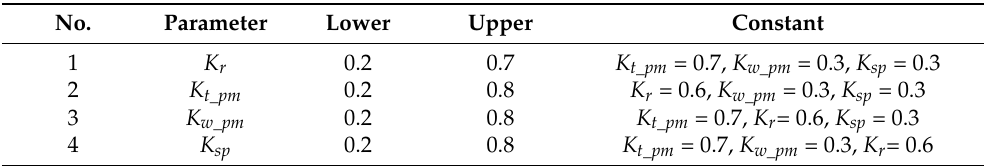
Table 2. The lower and upper parametric values and constants in each study.